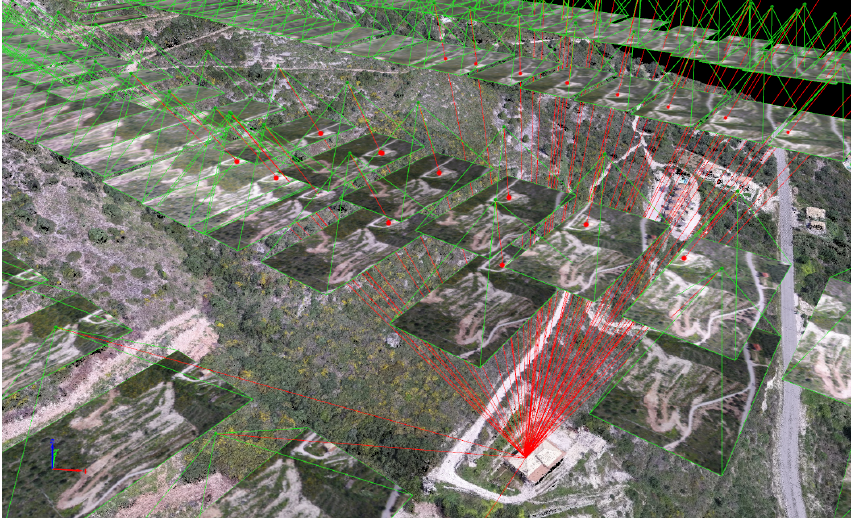
Figure 4. Schematic illustrating the overlap between pictures in the study site using SfM